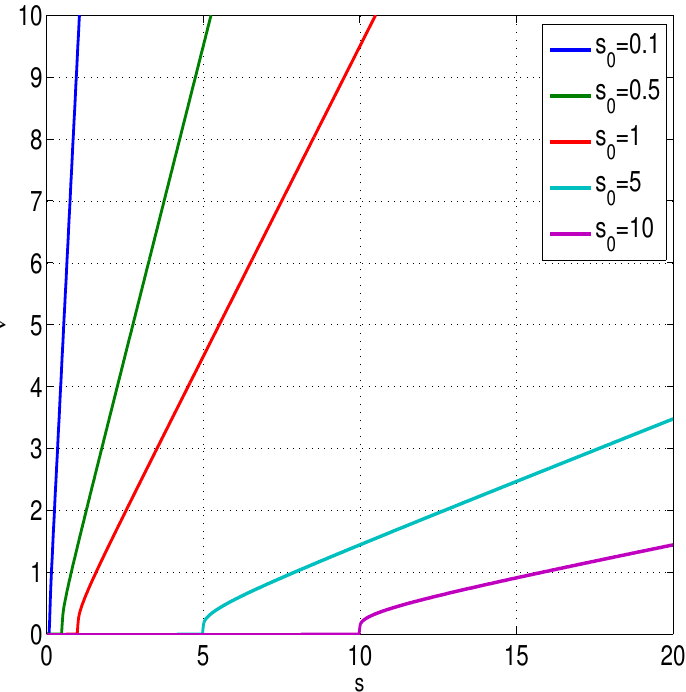
Figure 2. Dependence of the caustic rate ν ( s ) on Stokes number s in absence of